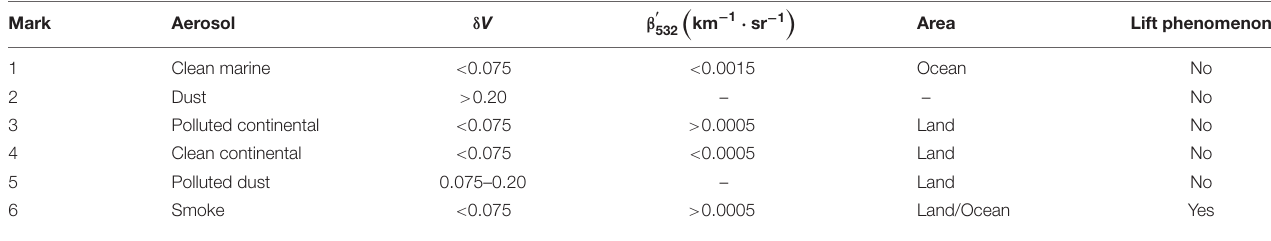
TABLE 1 | Level 2 dataset aerosol